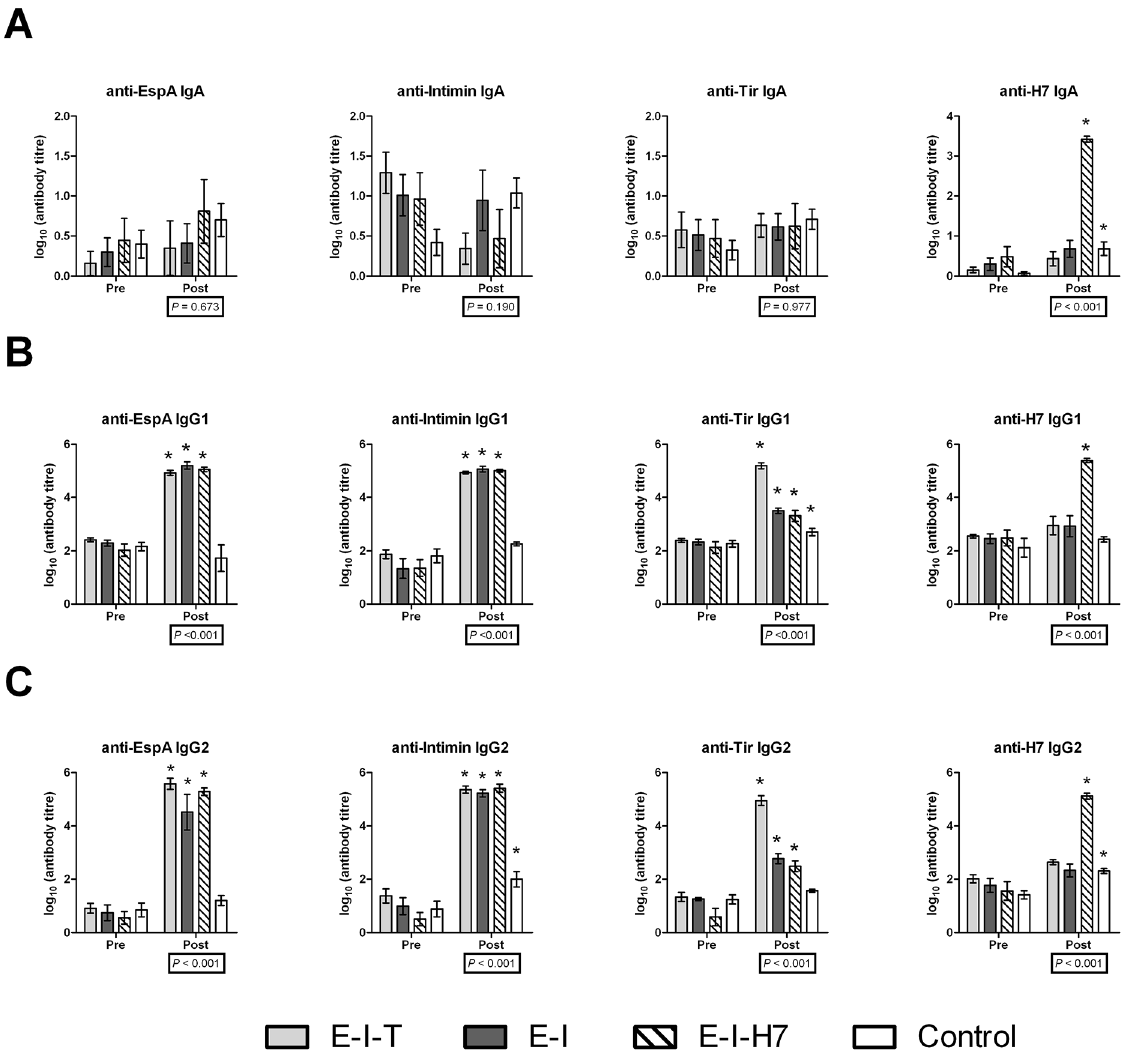
Fig 4. Serum antibody titres of different immunization groups. Mean titres of (A) IgA, (B) IgG1 and (C) IgG2 of EspA-, Intimin-, Tir- and H7 flagellin (H7)- specific antibodies within the serum of calves 2 days prior to the first immunization (Pre) and 6 days after the final immunization (Post) with either EspA, intimin and Tir ( E-I-T ), EspA and intimin ( E-I ), EspA, intimin and H7 flagellin ( E-I-H7 ), or adjuvant alone (Control). Each bar represents the mean (on log 10 scale) and corresponding error bar shows the standard error of mean. Overall statistical significance of immunization group for each antibody titre post- immunization was assessed using a linear mixed model and indicated by a p -value below each graph. The mean difference in titres between pre- and post- immunization for each immunization group was investigated using a linear mixed model, and statistically significant (adjusted for false discovery rate, p f < 0.05) changes are indicated by an asterisk ( *